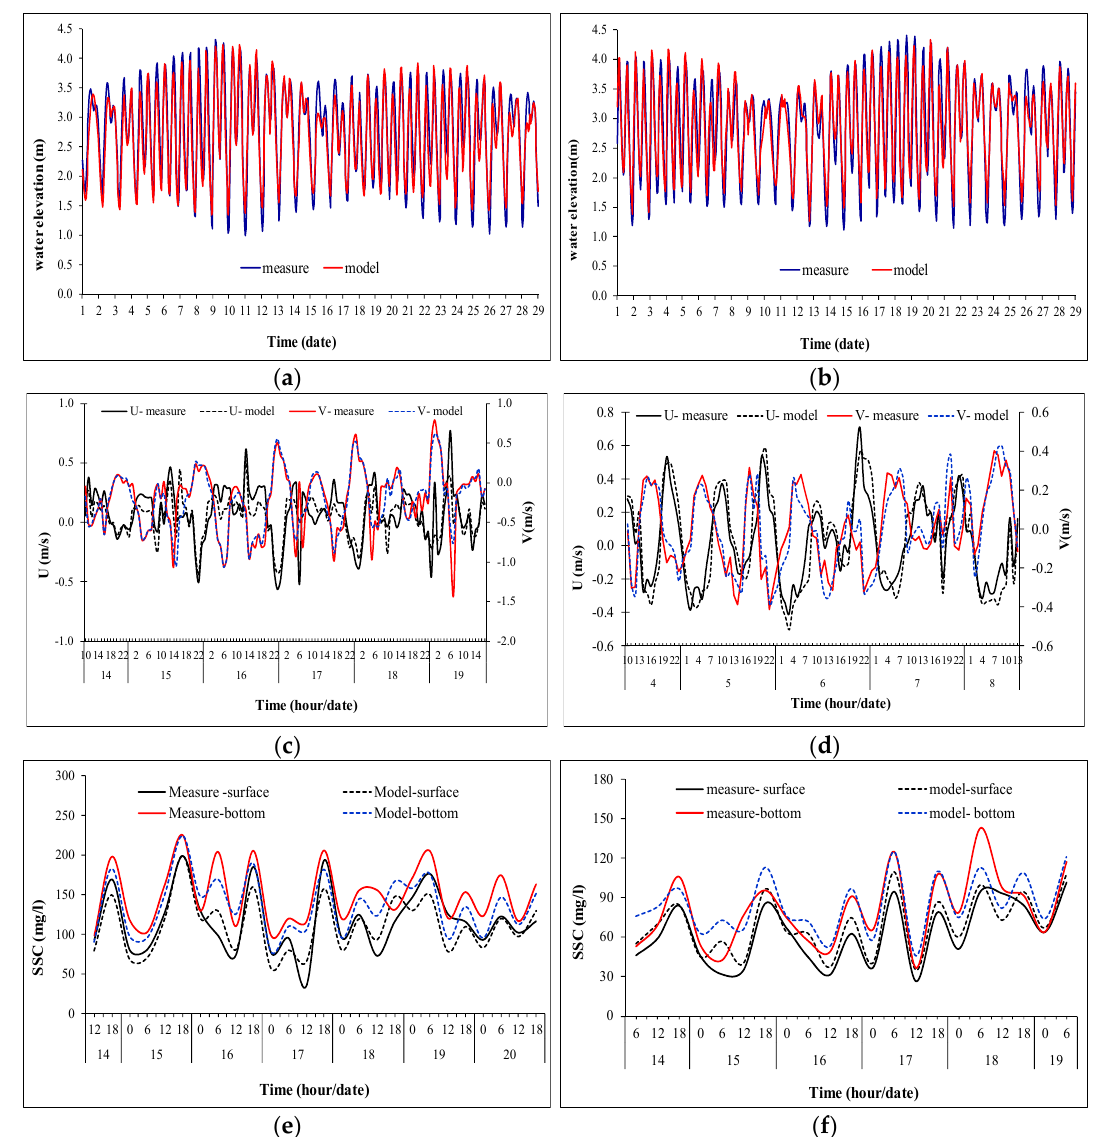
Figure 2. Comparison between simulations and measurements: ( a ) water elevation at B ế n Tr ạ i (C ổ Chiên mouth) in April 2012; ( b ) water elevation at B ế n Tr ạ i (C ổ Chiên mouth) in September 2012; ( c ) current components in the surface layer at LT1, flood season (14–19 September 2013); ( d )